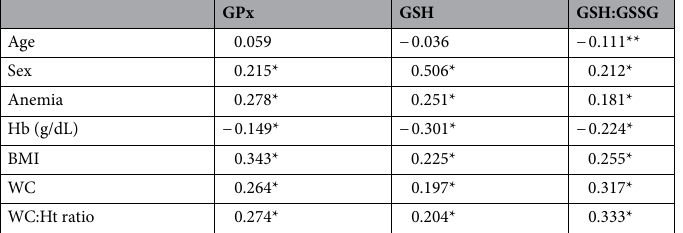
Table 5. Spearman’s correlation coefficient (ρ) for the correlation between redox status and measures of adiposity and anemia. Age, sex, and anemia were used as categorical variables, while BMI, WC, WC:Ht ratio, and Hb were used as continuous variables for assessing associations. GPx glutathione peroxidase, Hb hemoglobin, GSH reduced glutathione, GSSG glutathione disulfide, BMI body mass index, WC waist circumference, Ht height. *p < 0.01, **p < 0.05,